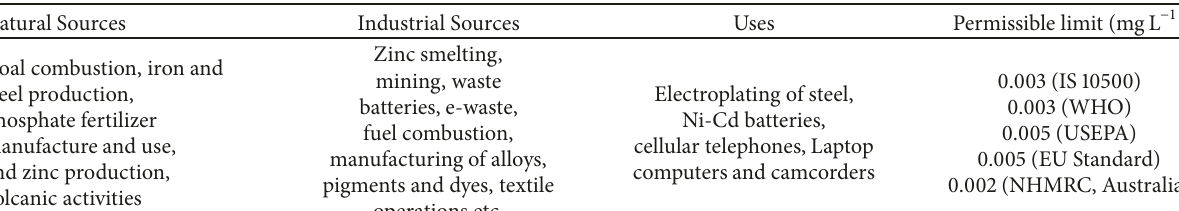
Table 2: Sources and permissible limits of Cd [49–52].